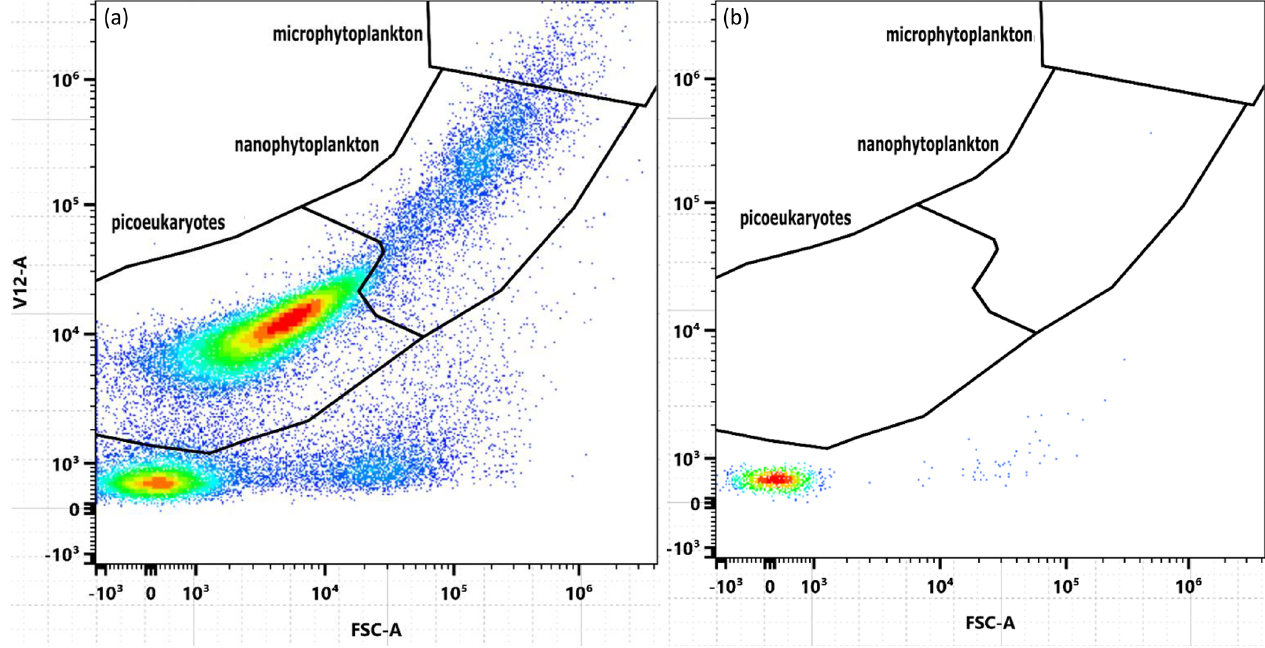
Figure A1. Cytograms used to determine the size of particles filtered by QMA filters used in TPC and TPN analysis. Plot (a) depicts a water sample filtered through a QMA filter (2.2µm) and plot (b) an unfiltered sample. Both plots were produced using the same sample from microcosm M4 on day